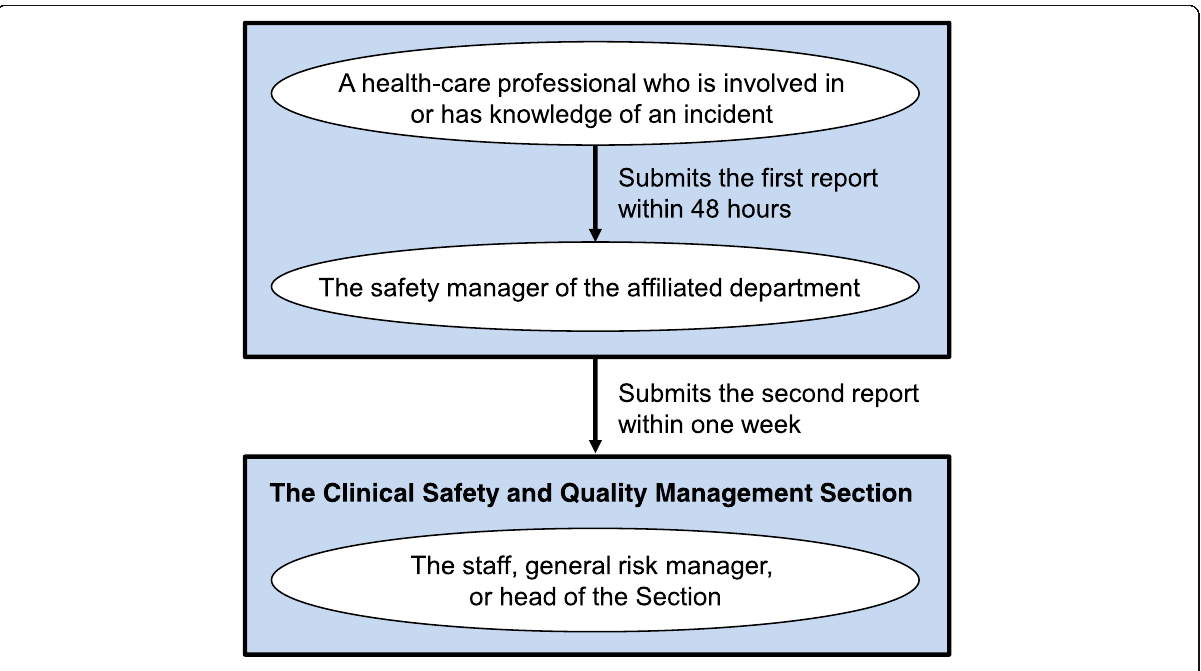
Fig. 1 Flow chart of the incident reporting